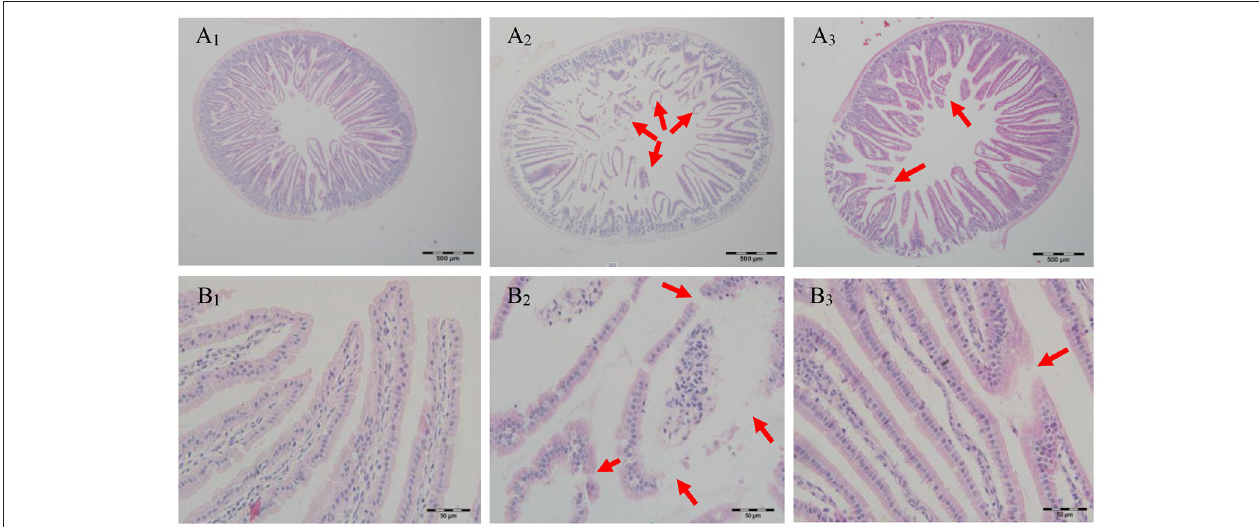
FIGURE 4 | Effect of oral administration with cAMP on jejunal morphology in PN-sensitized mice. Jejunum samples were fixed in 10% buffered formalin and embedded in paraffin. 5 µ m sections were stained with H&E and then the sections were examined under light microscopy at 40 (A) or 400X (B) magnification: (1) the CK group, (2) the PN group, and (3) the cAMP group. The red arrow indicates typical lesions.